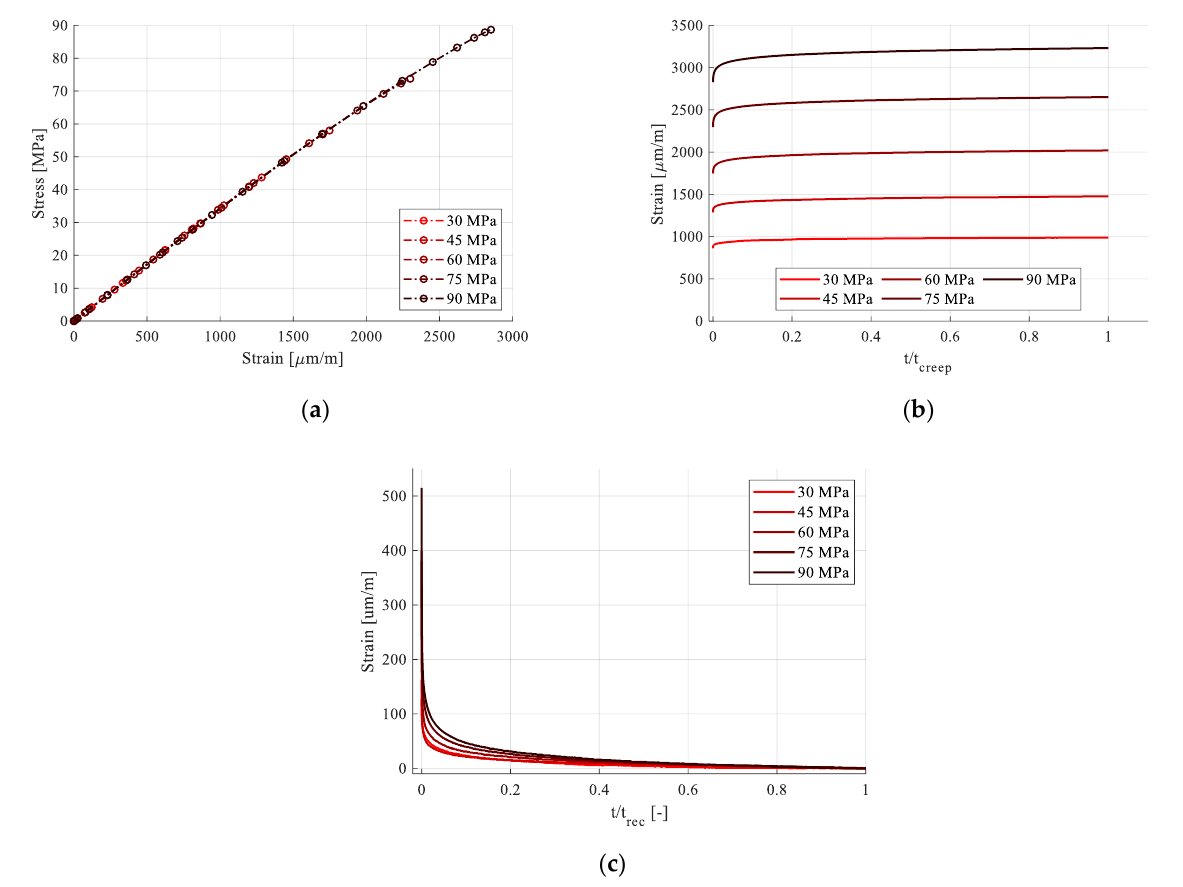
Figure 14. Loading phases of the creep-recovery cycles: ( a ) loading; ( b ) creep; ( c ) recovery. Table 5. Strain data from creep-recovery tests with regressive